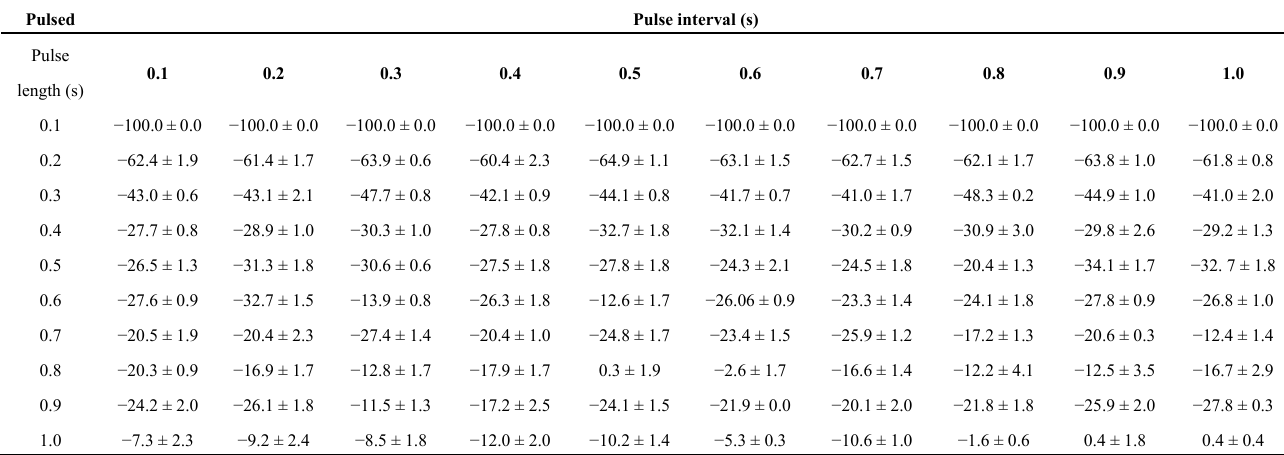
Table 1. PE values at each pulsed setting: pulse length (0.1–1 s), pulse interval (0.1–1 s).